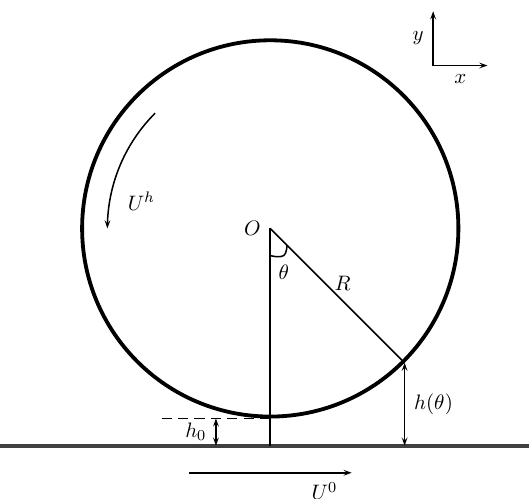
Figure 1. Cross-sectional geometry of an infinite cylinder rolling counter-clockwise on a plane. The fluid is between the cylinder and the flat surface. Reprinted from [14], with permission from